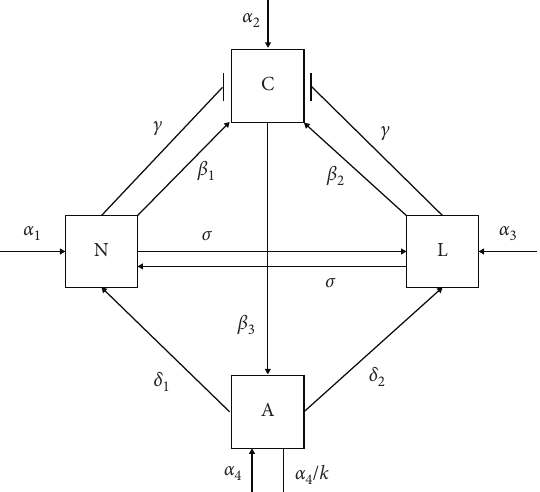
Figure 1: The transfer diagram of substances. The production, degradation, and interaction are denoted as arrow headed line. The inhibition is denoted as blunt